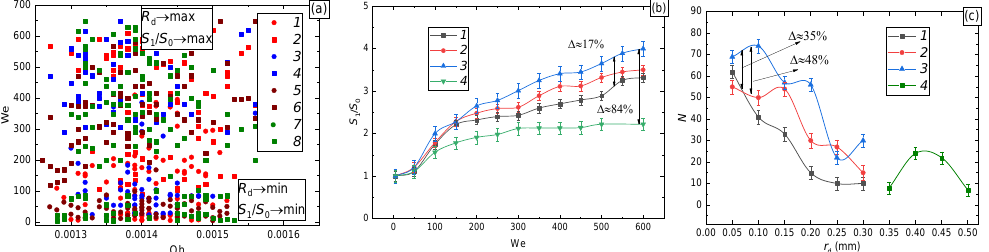
Figure 6. ( a ) Regime map of the drop impact on the wall (circle — deposition of the first drop and coalescence with all others, square — breakup) as a function of We(Oh) at a wall temperature of about 100 °С: 1, 2 — copper surface; 3, 4 — steel surface; 5, 6 — glass surface; 7, 8 — metal mesh; ( b ) S 1 / S 0 (We); ( c ) size distribution of child droplets at We = 200 and at different wall configurations: 1 — copper surface; 2 — steel surface; 3 — glass surface; 4 — metal mesh.